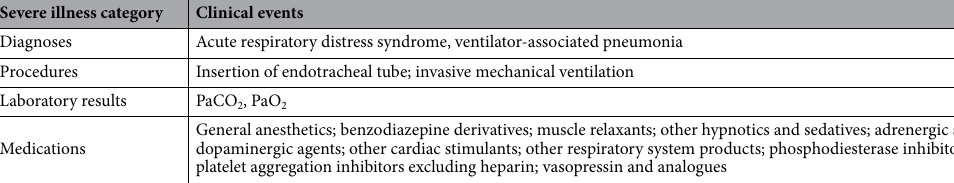
Table 2. The 4CE criteria of severe COVID-19. Comprising the occurrence of diagnoses, procedures, laboratory results and medications, this computational phenotyping algorithm of severity has been internationally validated (through manual chart review by local clinician experts at participating healthcare systems) to be a clinically reasonable proxy for hospitalized patients who experienced severe status of COVID- 19. This approach is applicable when the aggregate electronic health records data from each contributing healthcare systems are available but not the patient-level data. Please see Methods and further detail in a separate 4CE publication 30